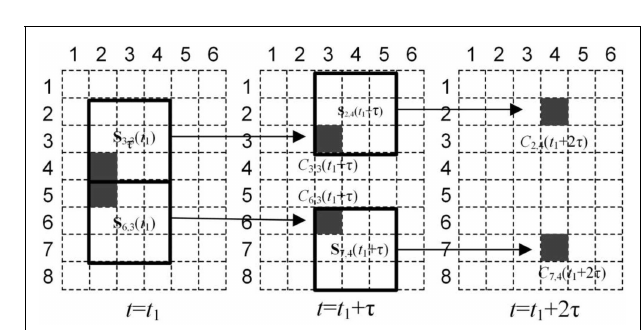
FIGURE 4 | Uncertainty of cells’ trajectories . (A) Occupancy state at time t. Filled squares represent occupied cells detected by UAVs. (B) and (C) are two different possible movements. (D) Occupancy state at time t + 1.